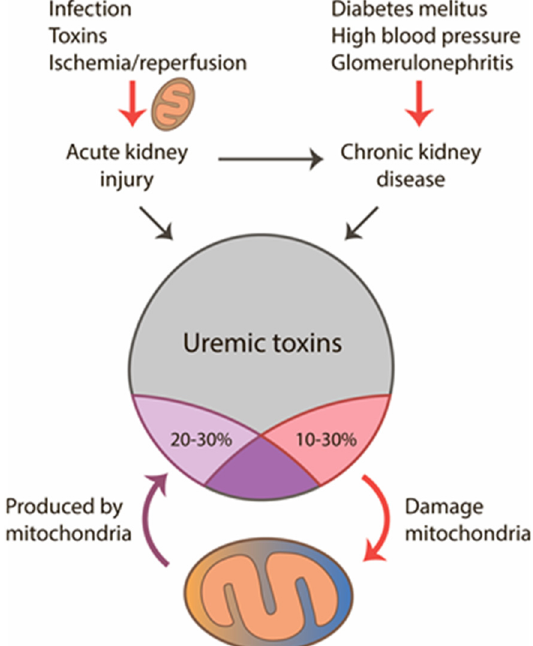
Figure 1. Interaction of mitochondria with uremic toxins in acute and chronic renal pathologies. Mitochondria are involved in the development of acute kidney injury (AKI), and later when uremia develops, mitochondria can act as a source and target for uremic toxins. From all uremic toxins, up to 30% could be produced by mitochondria and about 20% have damaging effects on the organelles.